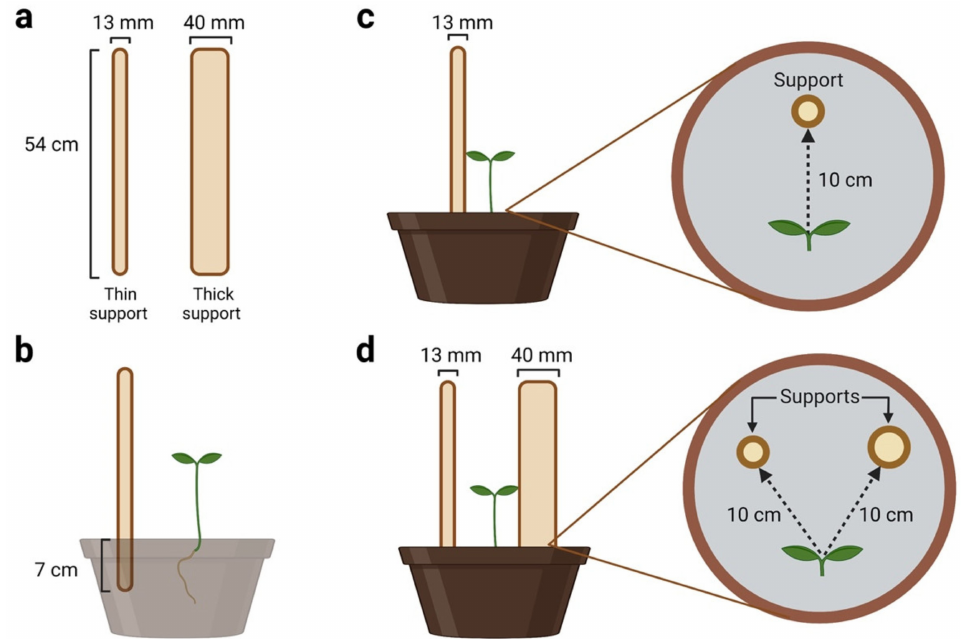
Figure 3. Graphical depiction of the ( a ) “thin” and “thick” supports; ( b ) the location of the support in the pot and how it was inserted in the soil. The single-support and double-support conditions are represented in panels ( c ) and ( d ),